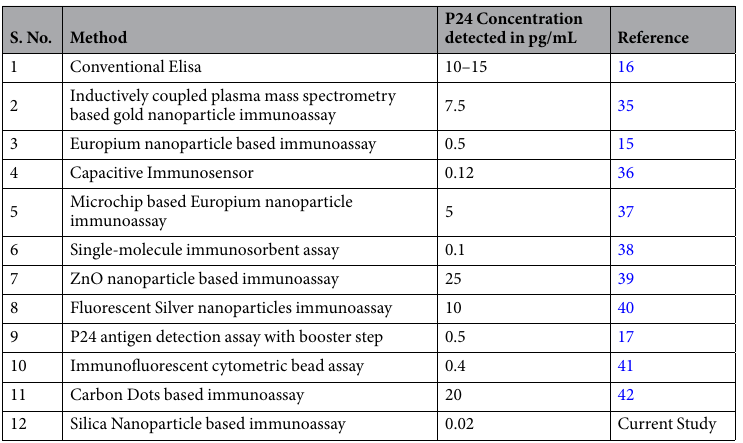
Table 3. Comparison of various techchnologies for the detection of p24